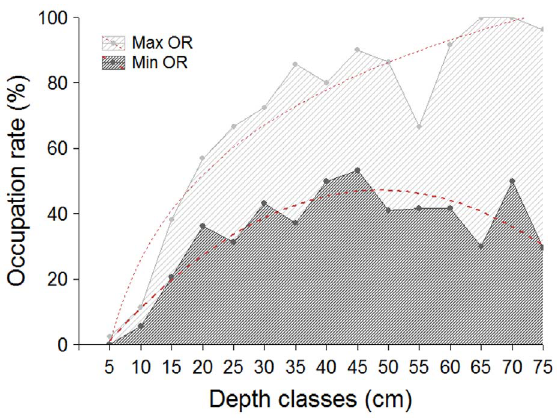
Figure 5. Minimum and maximum occupation rate according to depth. Occupation rates (minimum, dark gray; maximum, light gray) of burrows of Ocypode quadrata , according to their depth (n=491); dashed red lines represent the curve trend of each rate with increasing